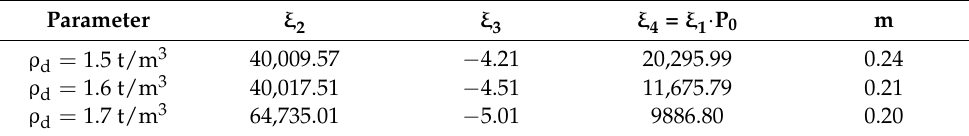
Table 2. Values of the model parameter fitting for the experimental